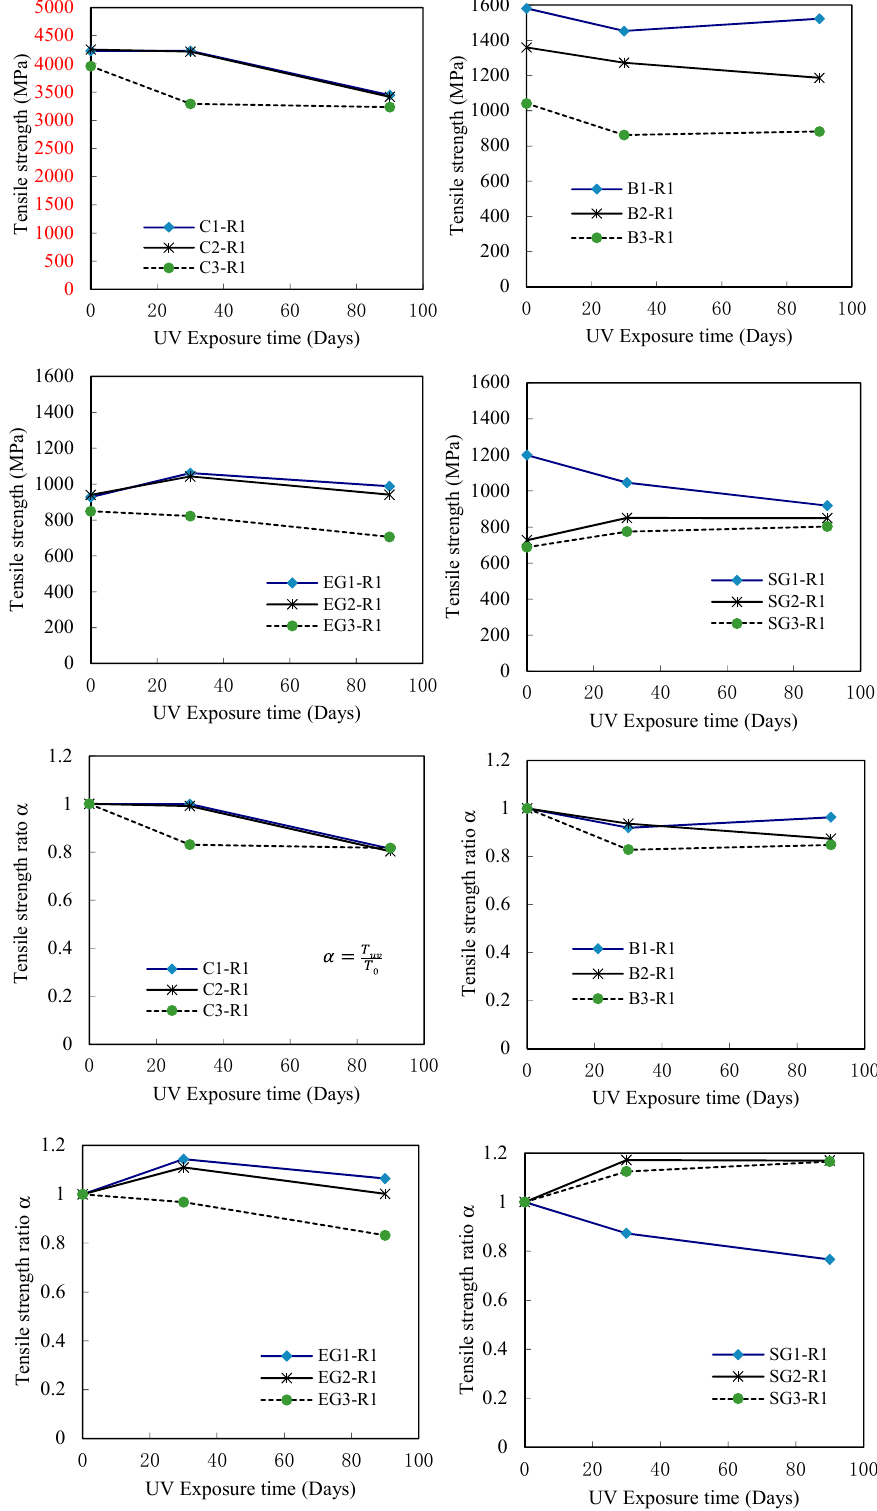
Figure 9. Effect of UV exposure on the tensile strength of FRP sheets with different layers (Resin No. 1).